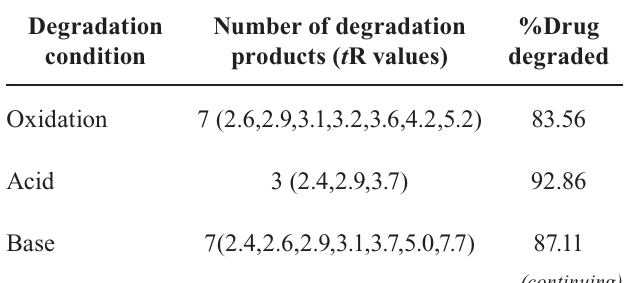
TABLE V - R esults of forced degradation studies